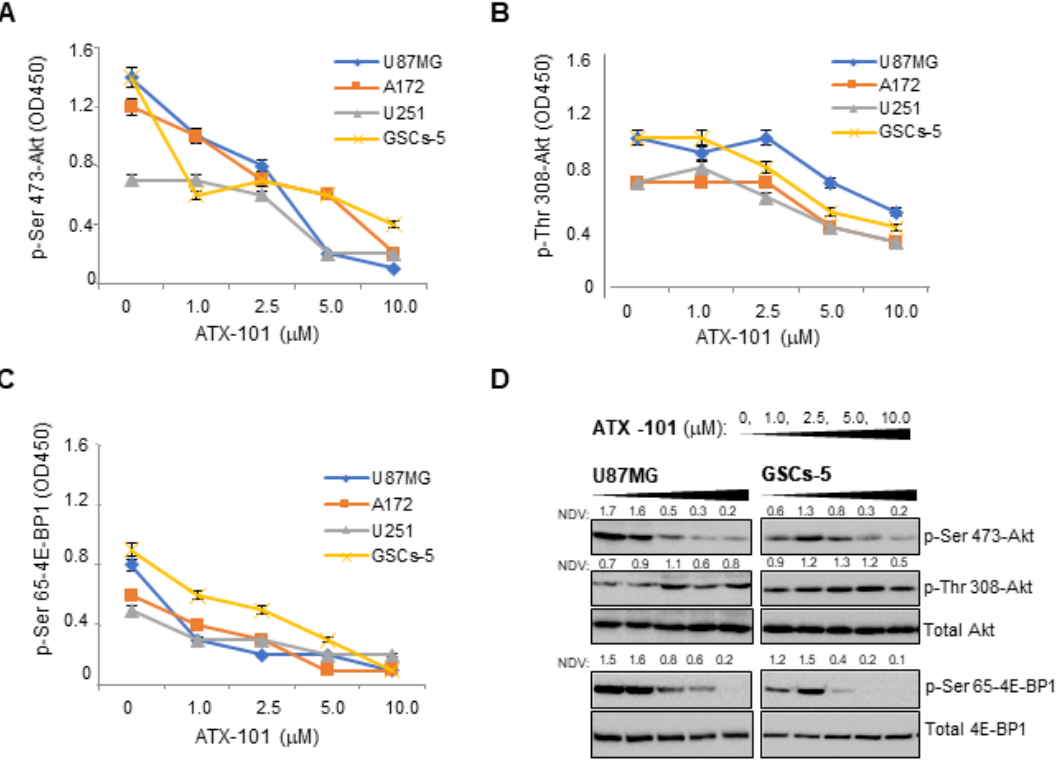
Figure 4. ATX-101 inhibits Akt activity in glioma cells. ( A – C ) U87MG, A172, U251, and GSCs-5 cells were treated with ATX-101 (1–10 μ M) for 8 h, fixed, and incubated with phospho-specific antibodies in an in-Cell ELISA; ( A ) p-Ser 473-Akt; ( B ) p-Thr 308-Akt; ( C ) p-Ser 65-4E-BP1. OD450 were collected from 5 replicates and given as mean ± SD. ( D ) Extracts from U87MG and GSCs-5 cells treated with ATX-101 (1–10 μ M) for 8 h analyzed for p-Ser 473-Akt, p-Thr 308-Akt, total Akt, p-Ser 65-4E-BP1, and total 4E-BPI by Western blot analysis. One representative out of 3 separated experiments with similar results is shown. Uncropped Western blots are shown in Supplementary Figure S4. NDV: Normalization of densitometric values of phosphorylated Akt and 4E-BP1 to nonphosphorylated isoforms are shown above the individual lanes.